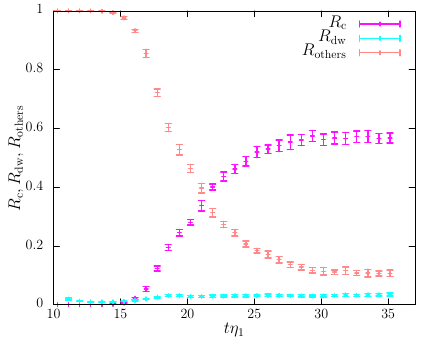
Figure 13 . The time-evolution of R c , R dw , and R others , for ( q 1 ; q 2 ; (cid:17) 2 =(cid:17) 1 ) = (1 ; 4; 0 : 25).